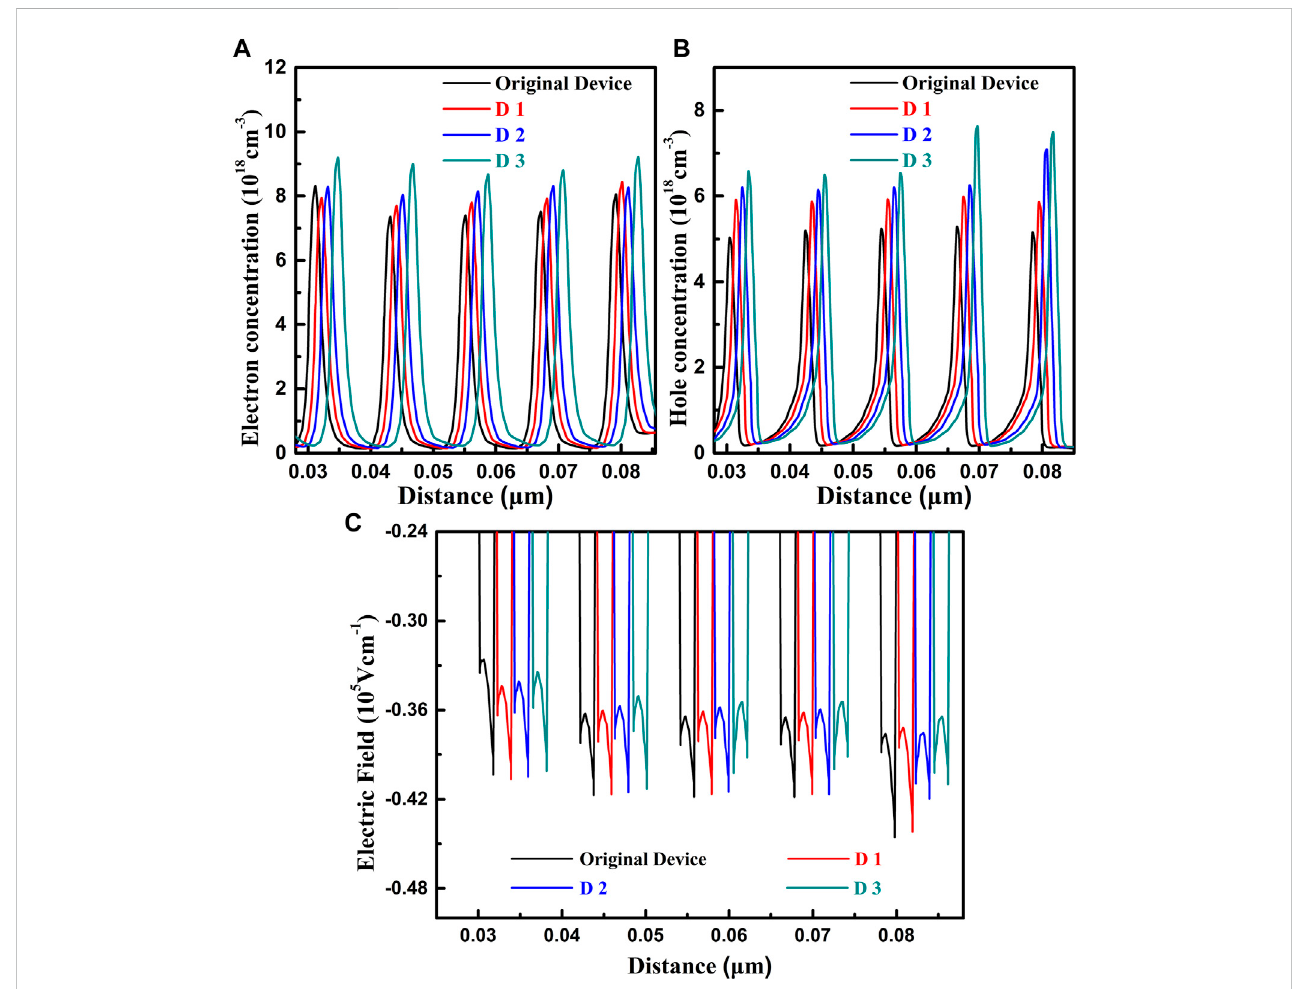
FIGURE 4 (Color online) (A) electron and (B) hole concentration of four structures at 200 mA. (C) The electric fi eld of four devices in the active region at 200